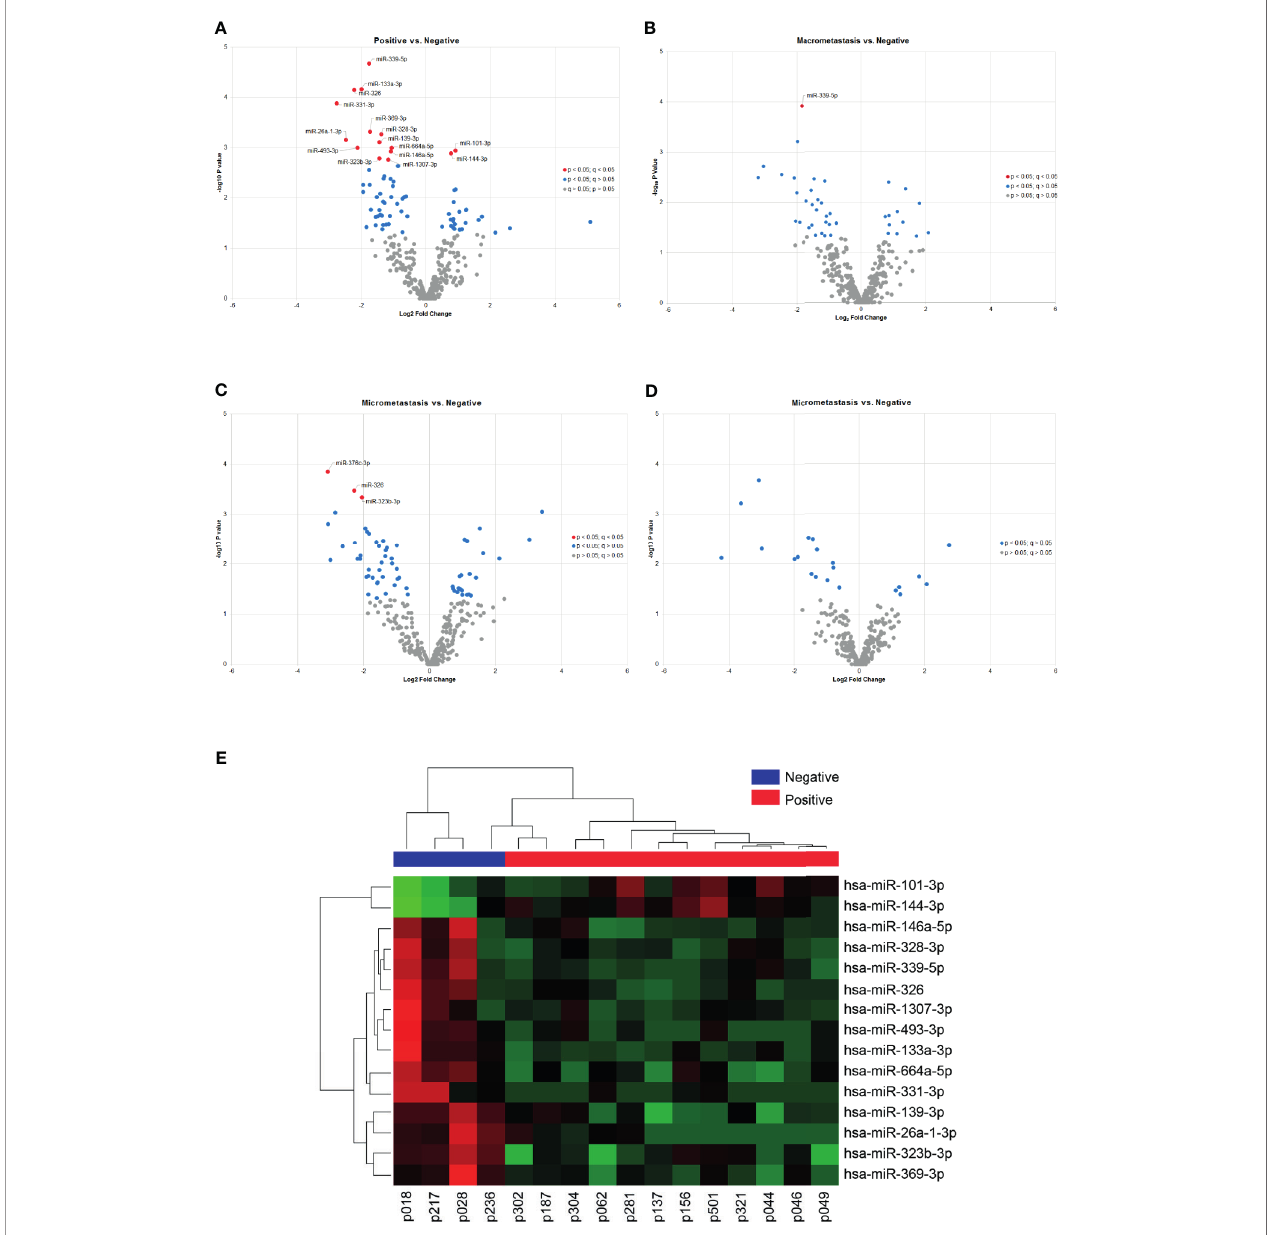
FIGURE 3 | Differentially expressed miRNAs according to the SLN status. (A – D) The volcano plots show differentially expressed miRNAs in plasma samples according to the patients ’ locoregional metastatic status as indicated. Only signi fi cant miRNAs with corrected q values < 0.05 are shown in the plots (red dots). The data show the relationship between non-adjusted p values (y-axis) and the fold change (x-axis) between the experimental groups. (E) Heat map and hierarchical clustering analyzed by samples and miRNAs. The analysis was performed using the 15 miRNAs differentially expressed between patients with positive and negative SLNs. Each row represents one miRNA and each column represents one sample. The color scale shows the expression level above (red) or below (green) the